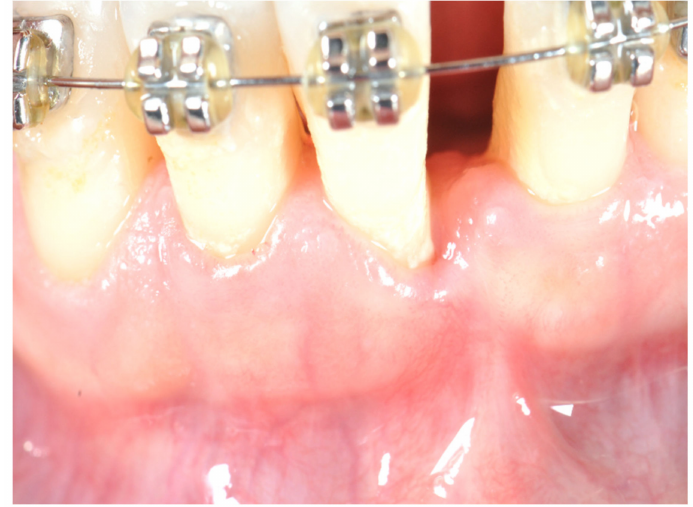
Figure 1. Initial situation at T0: Patient with lack of keratinized tissue and frenum pull on tooth #25.